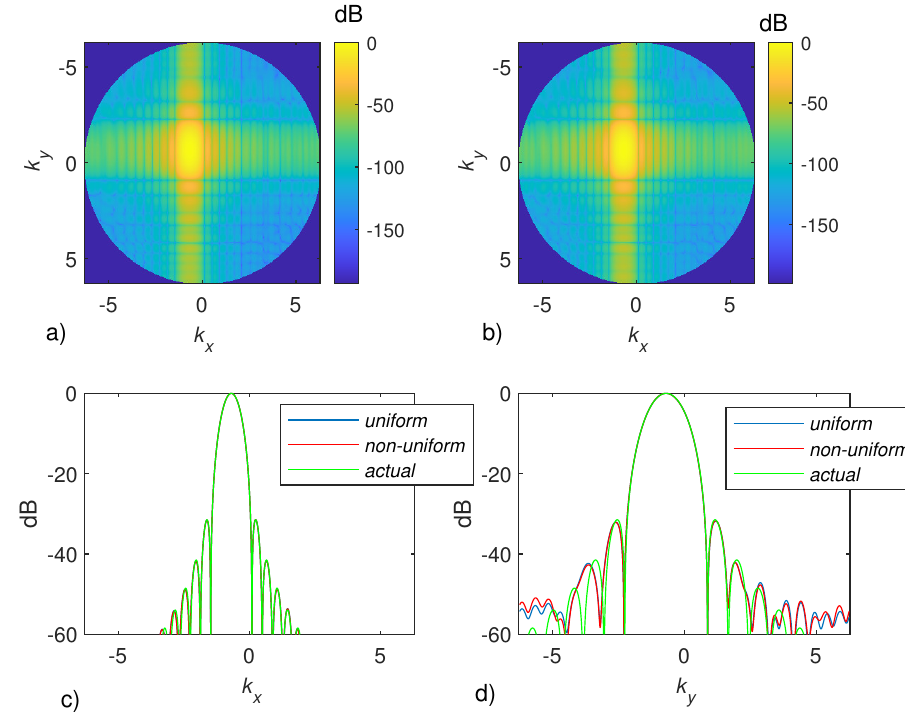
Figure 3. Normalized amplitude of the radiation pattern of J 1 ( x , y ) with X s = 8 λ , Y s = 4 λ , z o = 7 λ , X 0 = 10 λ and Y 0 = 6 λ . In ( a ), the radiation pattern is obtained by employing the near-field data according to the proposed non-uniform sampling scheme over the grid shown in ( a ) of Figure 2 and then interpolated over a λ /2 grid. In ( b ), the radiation pattern is obtained by directly employing the near-field data over a uniform λ /2 grid. Panels ( c , d ) have been obtained by fixing k y = k sin ( π /20 ) sin ( π /4 ) and k x = k sin ( π /20 ) cos ( π /4 ) , respectively, and compare the radiation pattern cut-views passing through the main-beam maximum. The green lines report the actual radiation pattern, the blue lines the radiation pattern computed by using the uniform λ /2 sampling and the red ones show the radiation pattern obtained by the proposed method. Noiseless